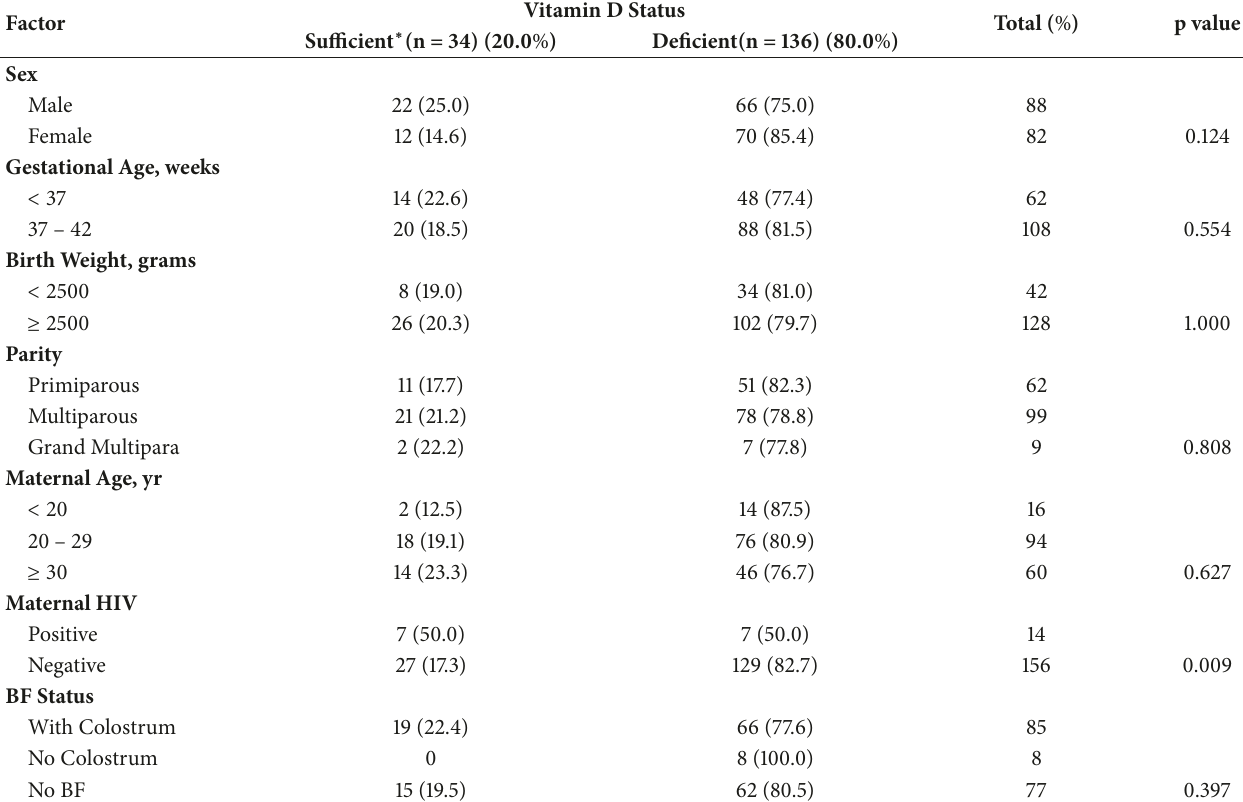
Table 2: Factors associated with vitamin d status.